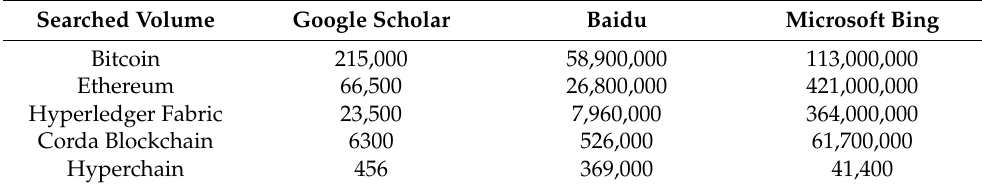
Table 3. Comparison of the searched volume of different blockchain platforms.